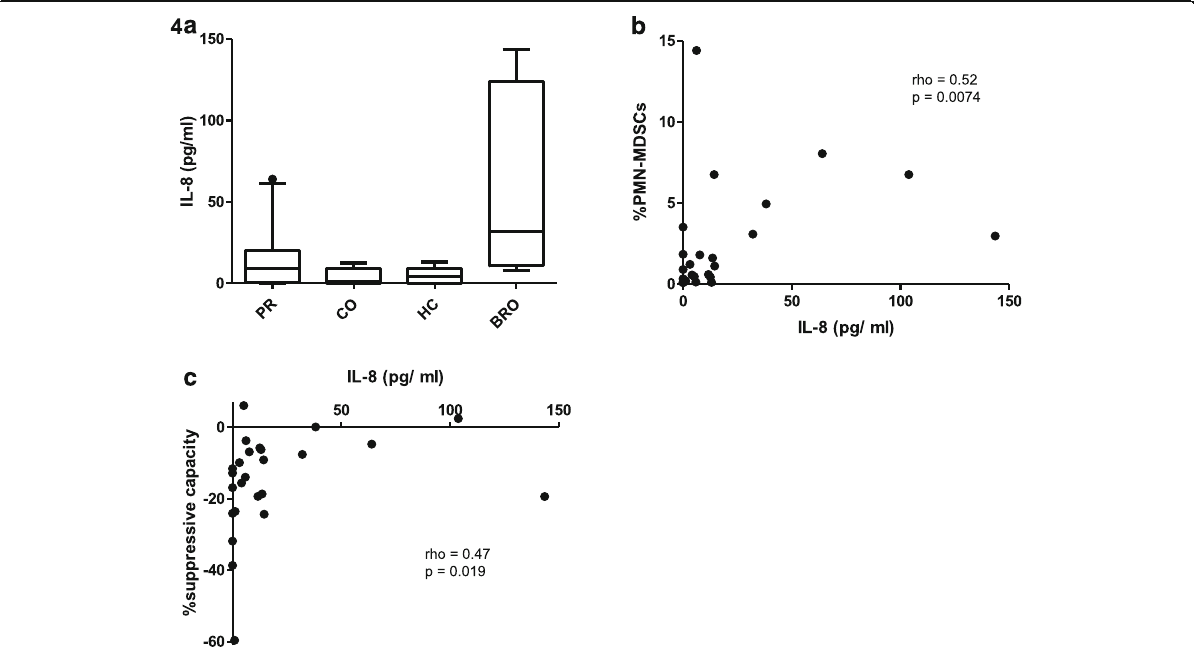
Fig. 4 Plasma levels of IL-8 and their correlation with the frequencies and suppressive capacity of PMN-MDSCs. a Plasma IL-8 levels were comparable in progressors (PR), controllers (CO), healthy controls (HC) and patients with lung cancer (BRO) ( p > 0.098); however, the Kruskal-Wallis test for the comparisons of more than two groups reached significance ( p = 0.037). b IL-8 levels correlated directly and significantly with frequencies (rho = 0.52, p = 0.0074) ( b ) and suppressive capacity (rho = 0.47, p = 0.019) ( c ) of PMN-MDSCs in all subjects. [PR: n = 10, CO: n = 5, HC: n = 5, BRO: n = 5, all subjects: n =